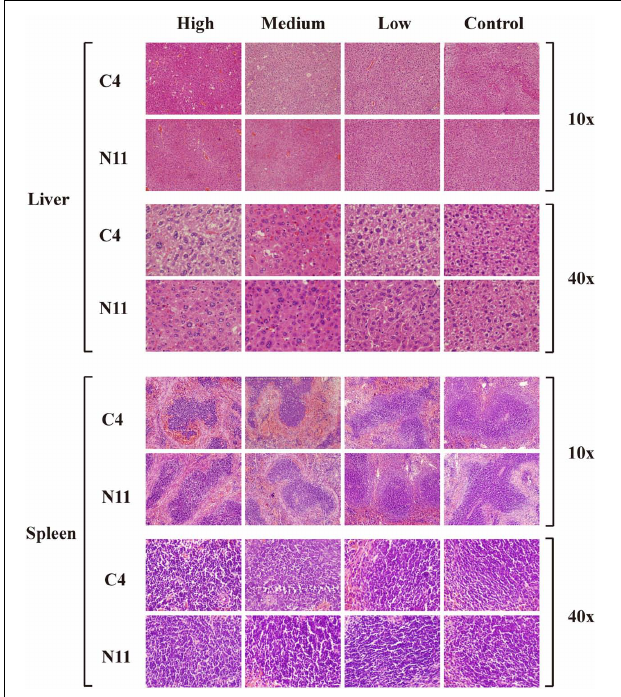
FIGURE 6 | Histological assessment of the liver and spleen of mice after infection by C4 and N11 strains.